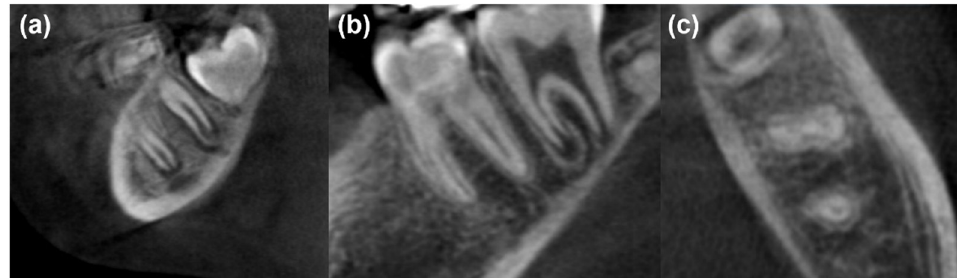
Figure 6. Cone-beam computed tomography (CBCT) analysis for some teeth after 12 months. ( a ) Sagittal view of incomplete apical closure in pulpotomy treatment using PRF; ( b ) sagittal view of complete apical closure in pulpotomy treatment using PRF; ( c ) axial view of complete apical closure in pulpotomy treatment using PRF.